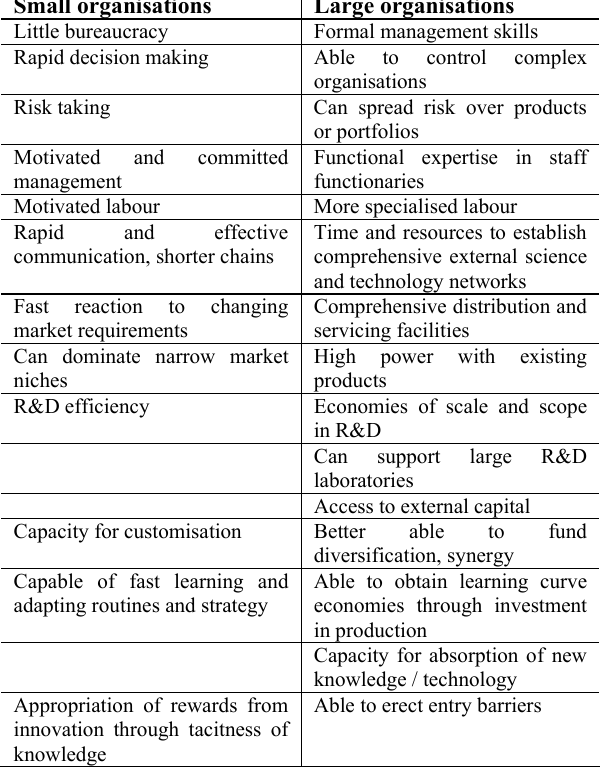
Table 6: Relative advantages of small and